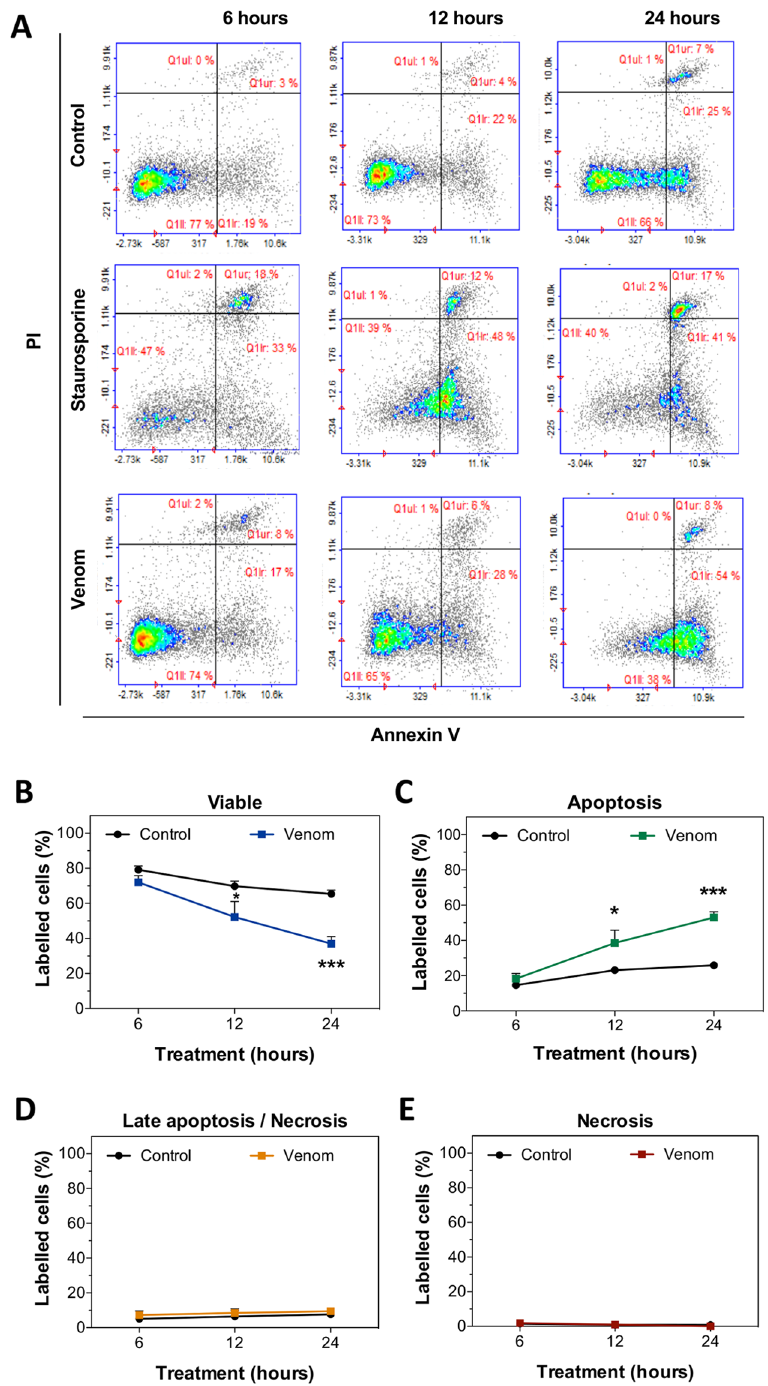
Fig 3. Apoptosis induced by L . m . muta venom in keratinocytes. (A) Representative cytometry plots for keratinocytes treated with staurosporine 1 μM for 3 hours, 2x EC 50 of L . m . muta venom for 6, 12 and 24 hours, or left untreated. Cells were stained with Propidium Iodide (PI) and Annexin V-FITC. B—E Graphs show the percentages of viable cells (B) , apoptotic cells (labelled with Annexin V) (C) , cells undergoing late apoptosis or necrosis (double labelled with Annexin V and PI) (D) or necrotic cells (labelled with PI) (E) . Data are represented as means ± SEM (n = 3, data were collected from three independent experiments). Venom-treated groups were compared to their control using two-way ANOVA ( (cid:3) p < 0.05, (cid:3)(cid:3)(cid:3) p <